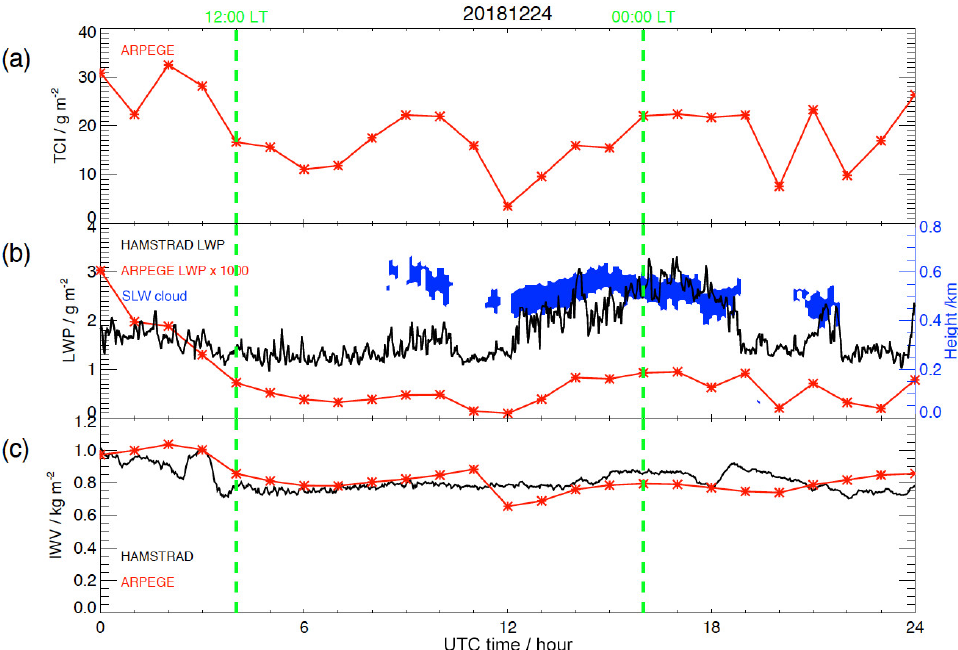
Figure 4. Diurnal variation on 24 December 2018 (UTC time) of (a) the total column of ice (TCI) (gm − 2 ) calculated by ARPEGE-SH (red crossed line), (b) the liquid water path (LWP) measured by HAMSTRAD (gm − 2 , black solid line) and calculated by ARPEGE-SH ( × 1000gm − 2 , red crossed line), and (c) the integrated water vapour (IWV, kgm − 2 ) measured by HAMSTRAD (black solid line) and calculated by ARPEGE-SH (red crossed line). Superimposed on panel (b) is the SLW cloud thickness (blue area) deduced from the lidar observations (see Fig. 1c) (blue y axis on the right of the figure). Note LWP from ARPEGE-SH has been multiplied by a factor of 1000. Two vertical green dashed lines indicate 12:00 and